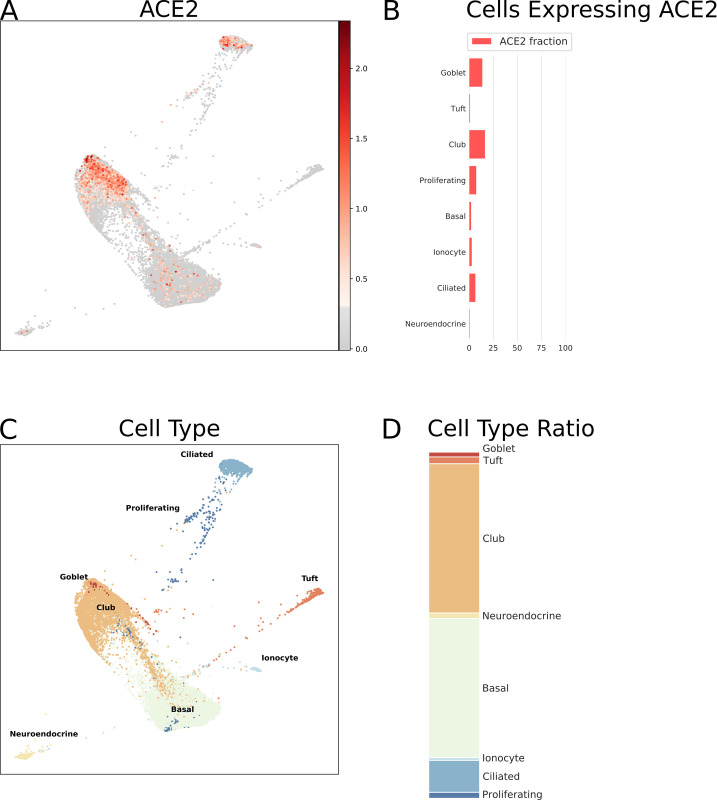
Single cell RNA-Seq analysis of different cell types from the respiratory tract (mouse tracheal epithelium), derived from data from GEO dataset GSE103354 [51].ACE2 mRNA expression as normalized, batch-corrected counts is shown for comparison in upper panel. The force directed layout plot was computed and visualized in ScanPy [54]. For each cell type the ratio of cells expressing ACE2 is presented in addition to a stacked barplot of the relative cell type frequencies in the whole dataset.